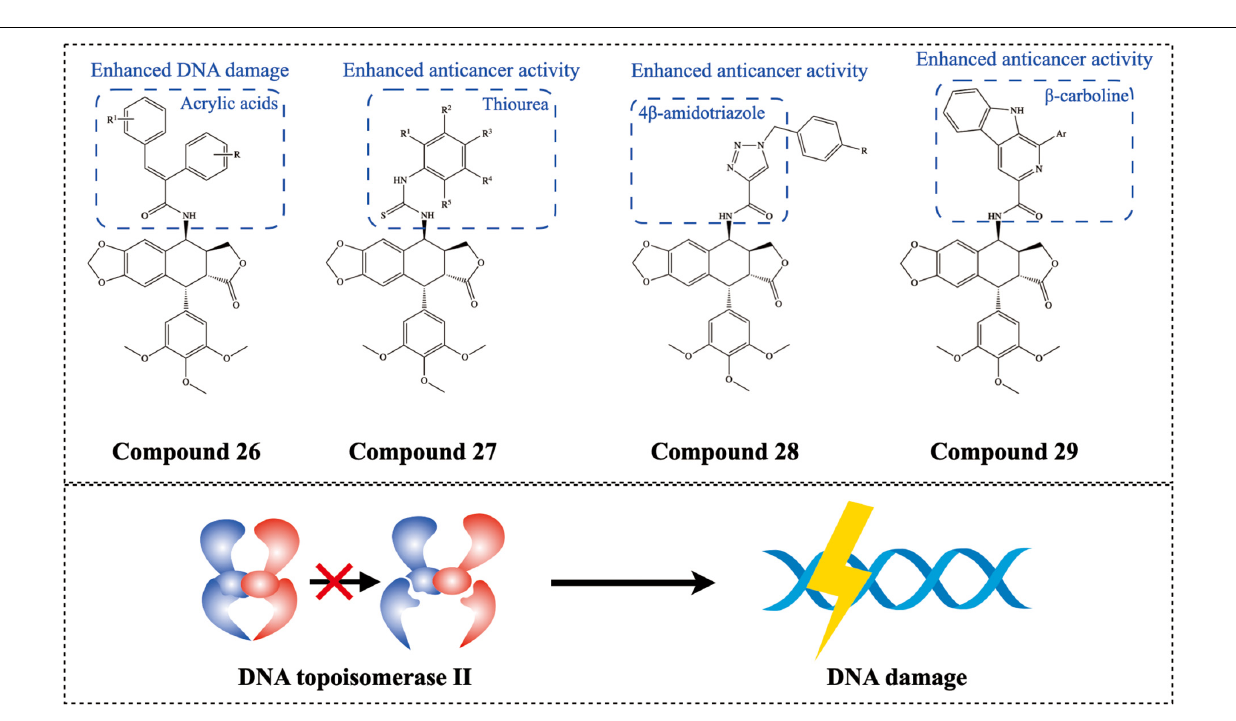
to normal human cell lines. Furthermore, L1EPO downregulated the mdr-1 gene and reduced the expression of P-gp, which may be the mechanism of its anti-MDR effect. Similarly, YB- 1EPN Compound 31 ( Figure 9 ) as a PTOX derivative also